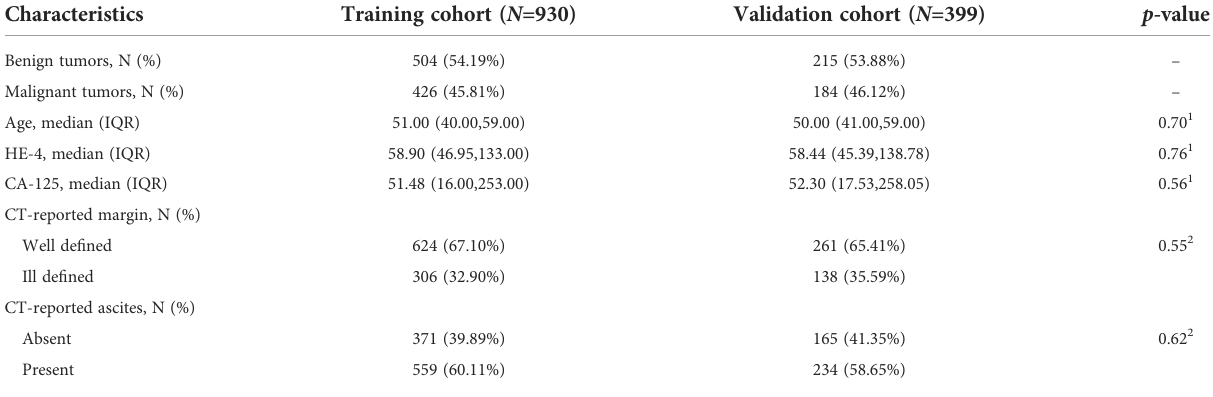
TABLE 2 Patients characteristics.